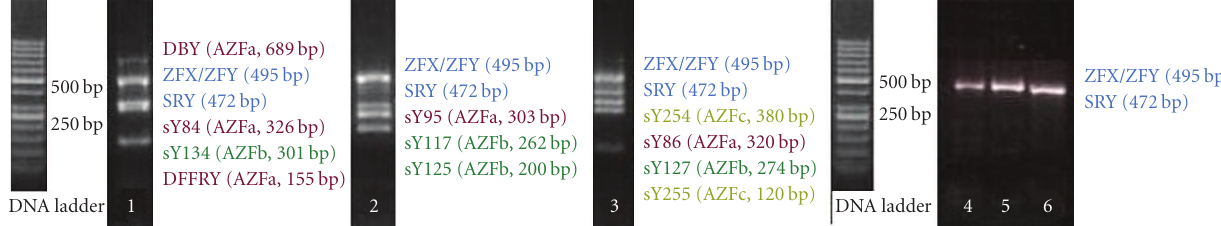
Figure 1: Photos of 3% high-resolution agarose (mucinous agarose) gel electrophoresis of the three multiplex PCR amplicons from the patient’s DNA (genomic DNA was isolated from venous blood cells) and control DNA. Band patterns of the control DNA: 1, 2, and 3, band patterns of the patient’s DNA: 4, 5, and 6.